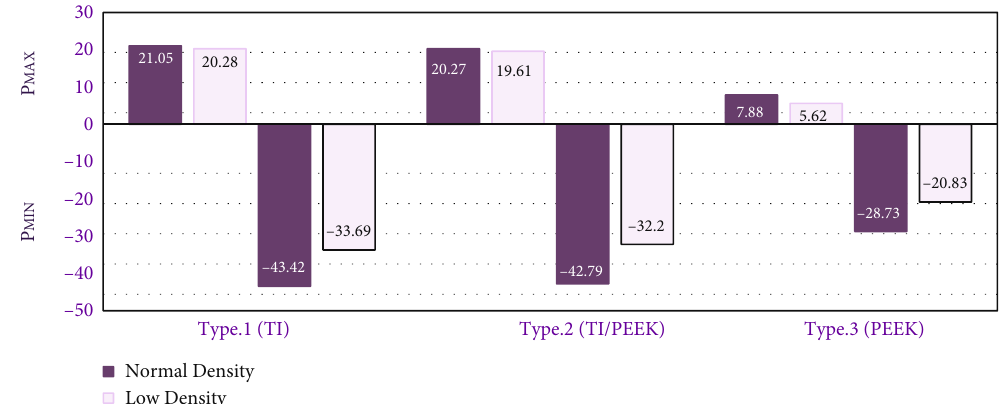
Figure 7: Maximum and minimum principal stresses (MPa) on cortical bone.